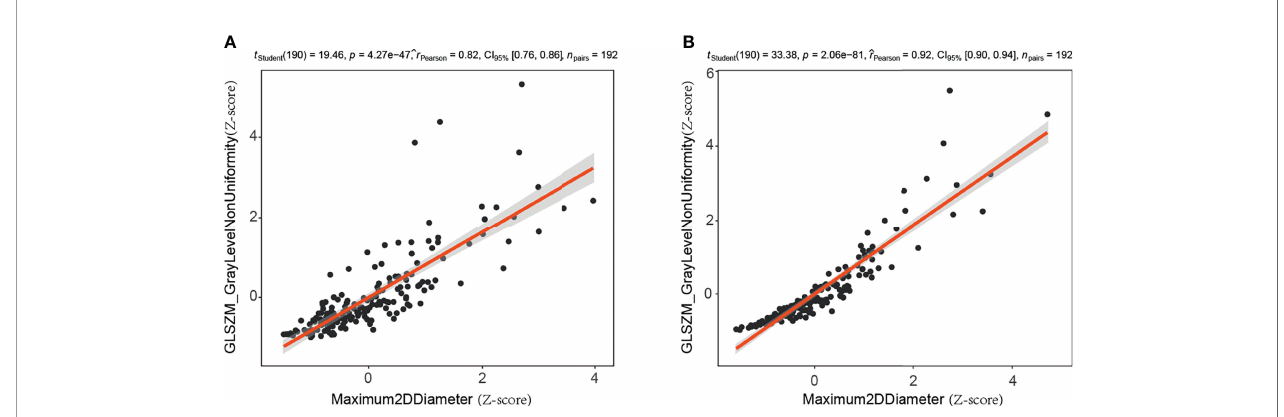
FIGURE 5 | Correlation analysis of maximum two-dimensional diameter and gray level non-uniformity (gray-level size zone matrix based) in training set. (A) Craniocaudal (CC) position images; (B) mediolateral oblique (MLO) position images. 2D, two-dimensional; GLSZM, gray-level size zone matrix.